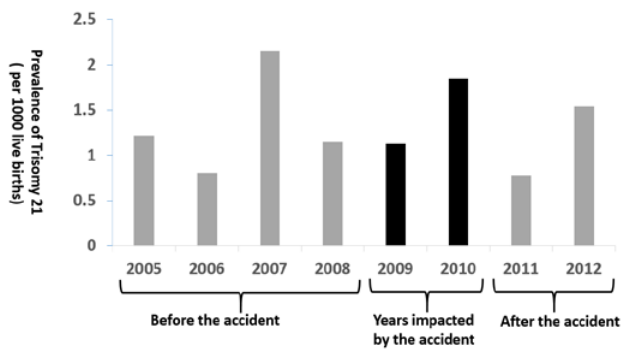
Figure 3. Prevalence of Trisomy 21 in 2005–2012 in Brazos County, Texas.